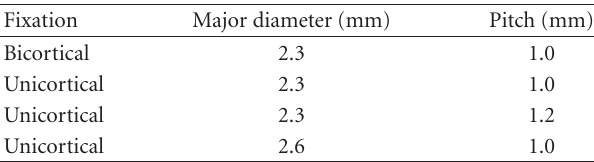
Table 3: Di ff erent screw configurations used in the FEA screw